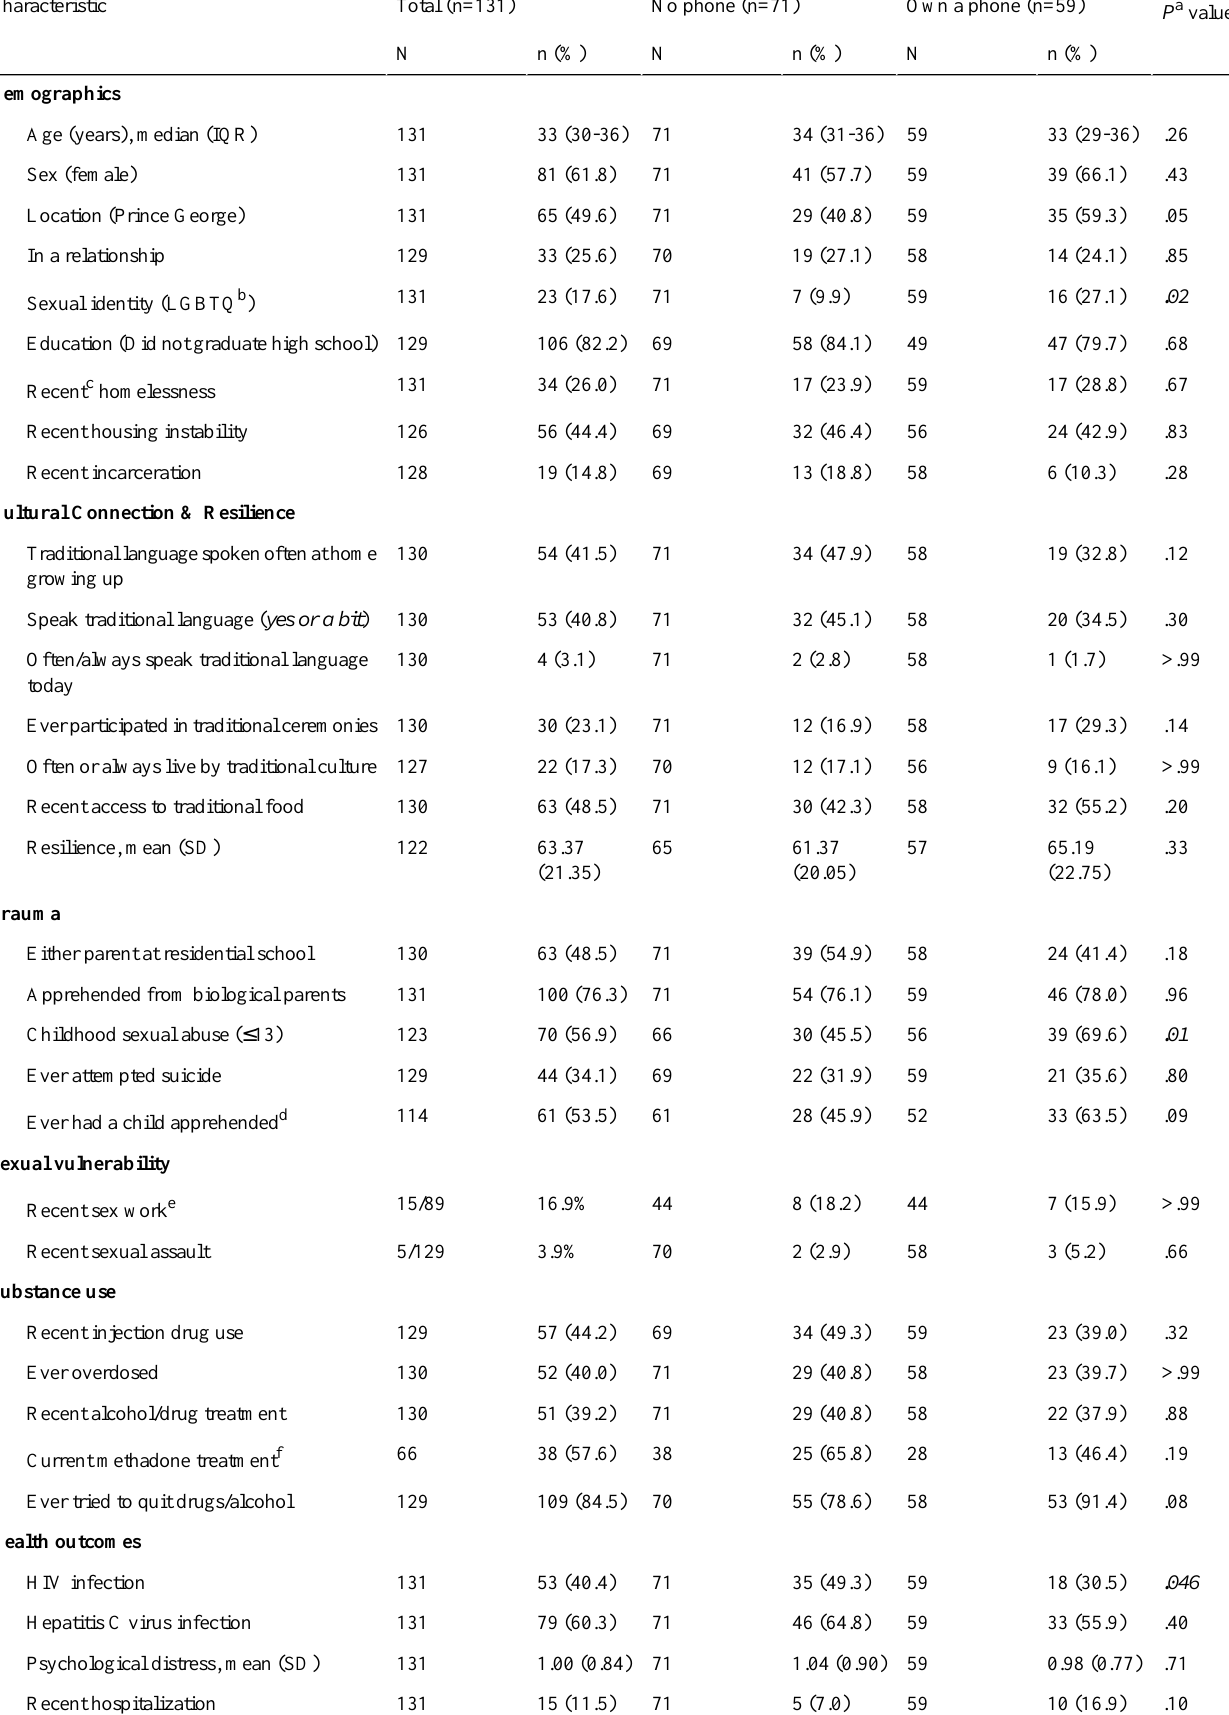
Table 1. Characteristics of young Indigenous people who have used drugs enrolled in the Cedar Project WelTel mHealth Program by phone